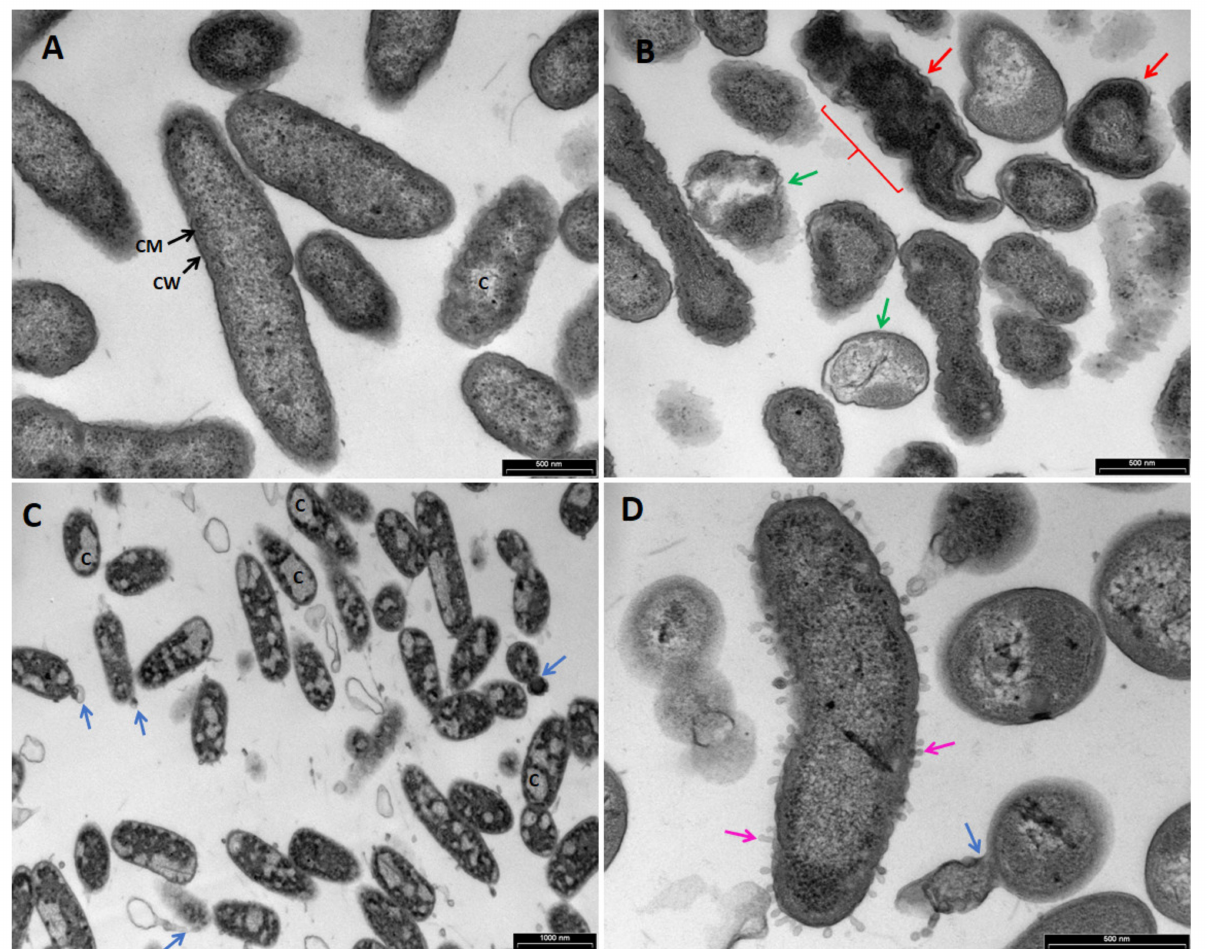
Figure 6. TEM images of Pseudomonas aeruginosa treated with ( A ) H 2 O, no-treatment control, ( B ) maltol at 4500 ppm, ( C ) DDAC at 500 ppm, ( D ) blend of maltol and DDAC (95:5) at 5000 ppm. Green arrows: loss of intracellular material. Red line and arrows: over-folding of the membrane and loss of rod shape, replaced by irregular structure. Blue arrows: membrane bound segments extending from the cell membrane. Pink arrows: bleb-like vesicles burgeoning from the bacterial surface. Abbreviations: C: cytoplasm, CM: cell membrane, CW: cell wall.